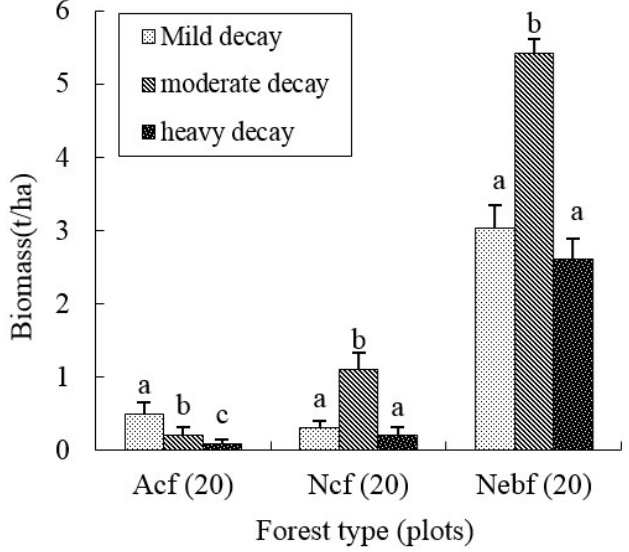
Figure 3. Biomass of fallen trees of different decay classes. Different lowercase letters indicate significant differences among different decay classes of the same forest type ( Acf , Ncf or Nebf ) ( p < 0.05). Table 5. Biomass of fallen trees of decay classes in different stand and forest types.